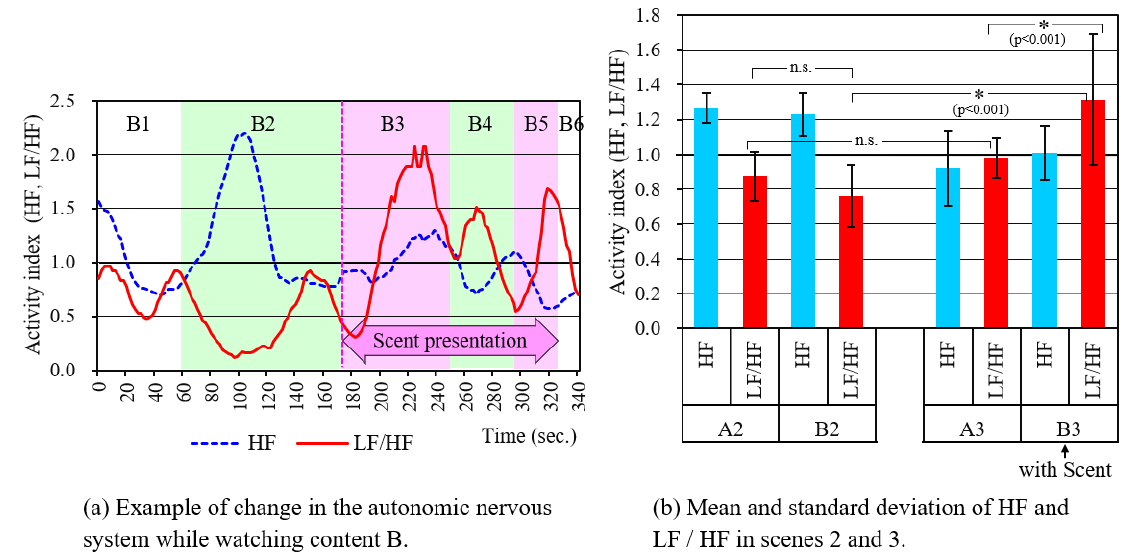
Figure 10. Autonomic nervous system measurement results.